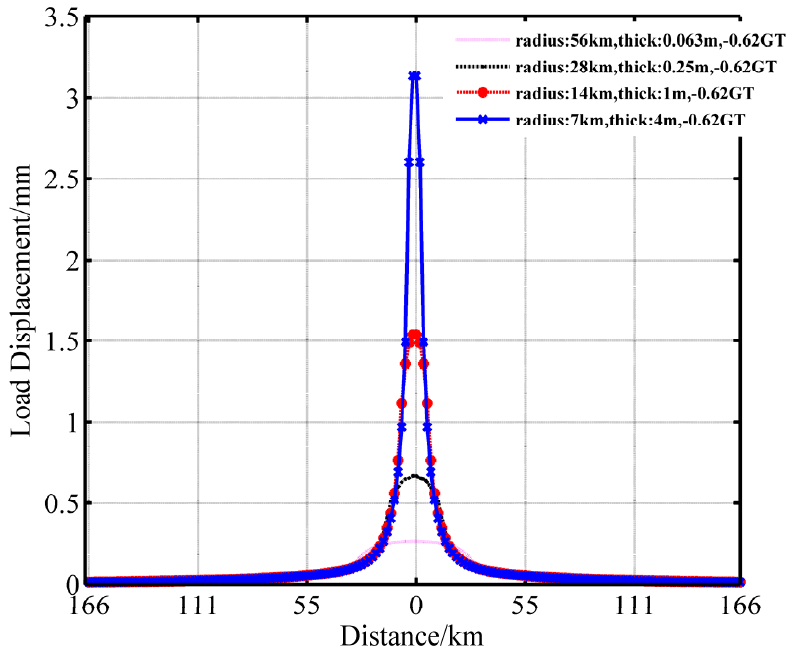
Figure 3. Vertical deformation caused by disks of different masses.